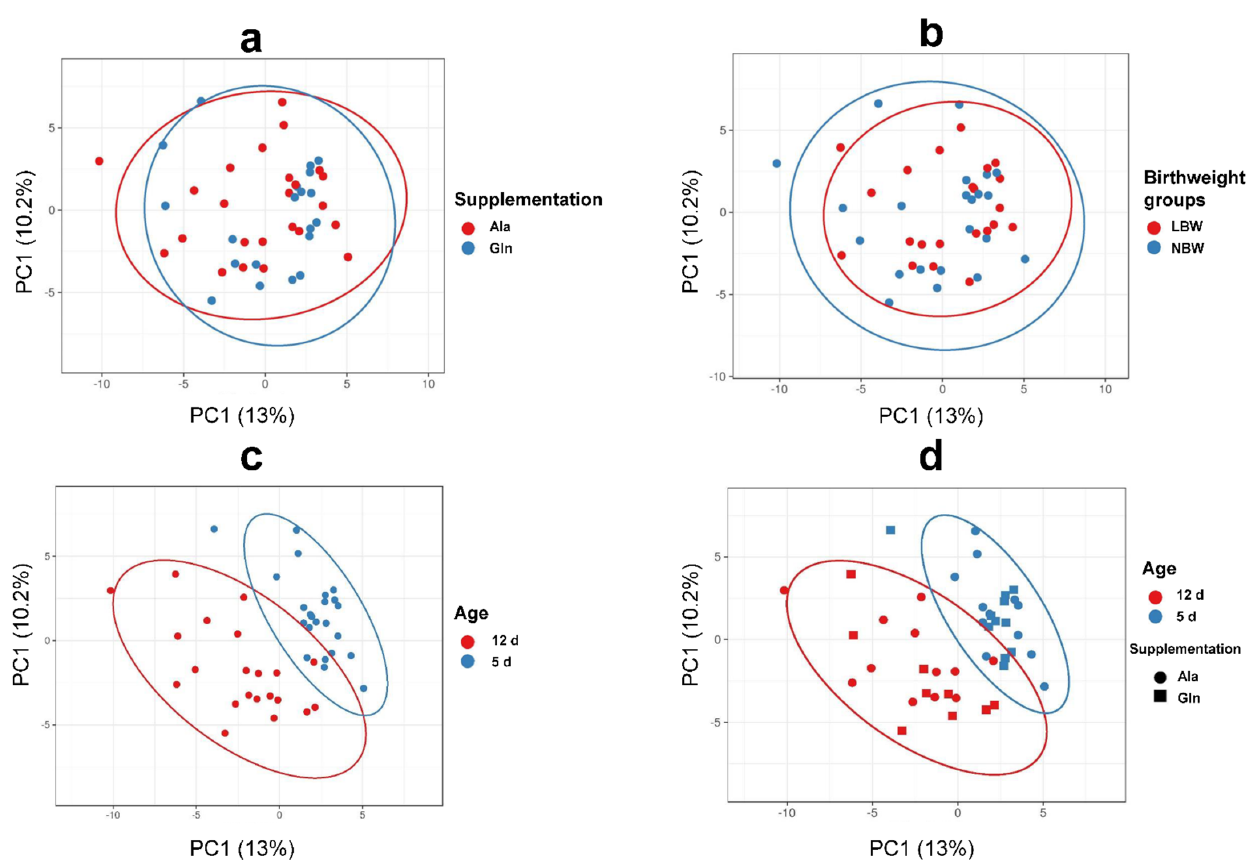
Figure 2. Principal component analysis (PCA). Principal component analysis (PCA) showing the effect of ( a ) supplementation; ( b ) birthweight; ( c ) age; ( d ) age and supplementation × birth weight on bacterial genus level. Ala = Alanine, Gln = Glutamine, LBW = low birthweight, NBW = normal birthweight. PCA was performed with Clustvis.